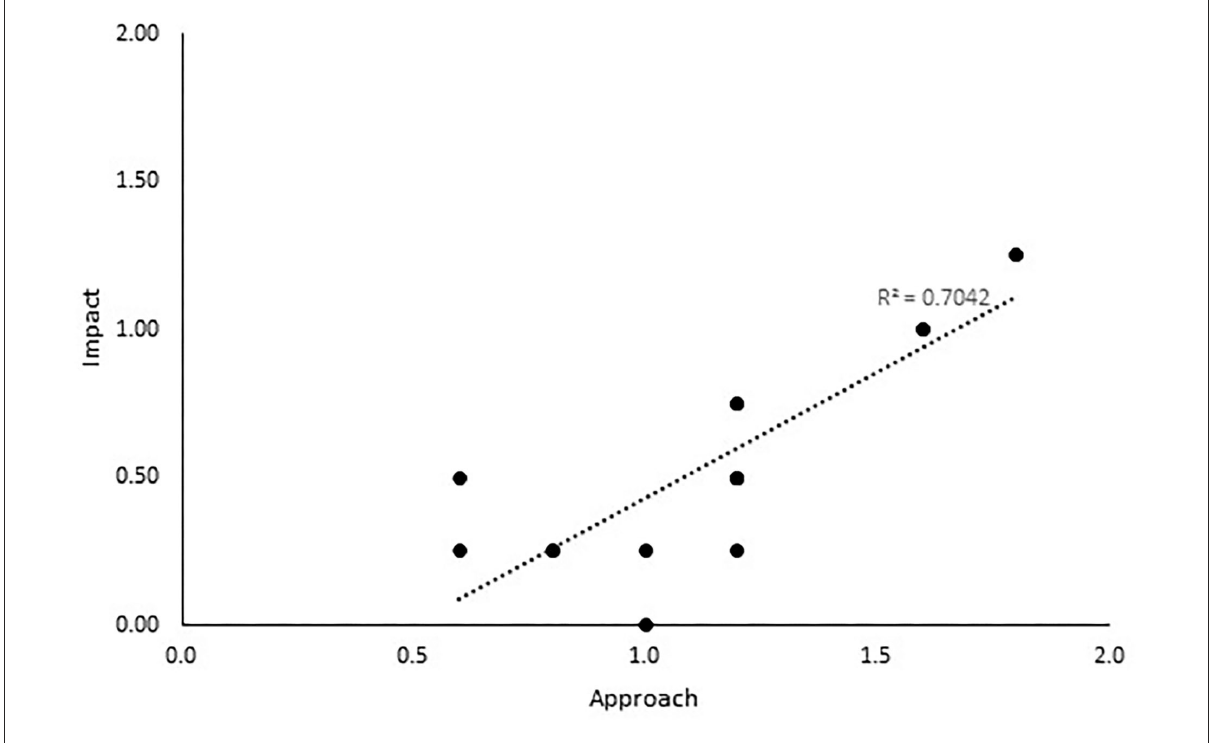
FIGURE3 Relationship between project approach and project